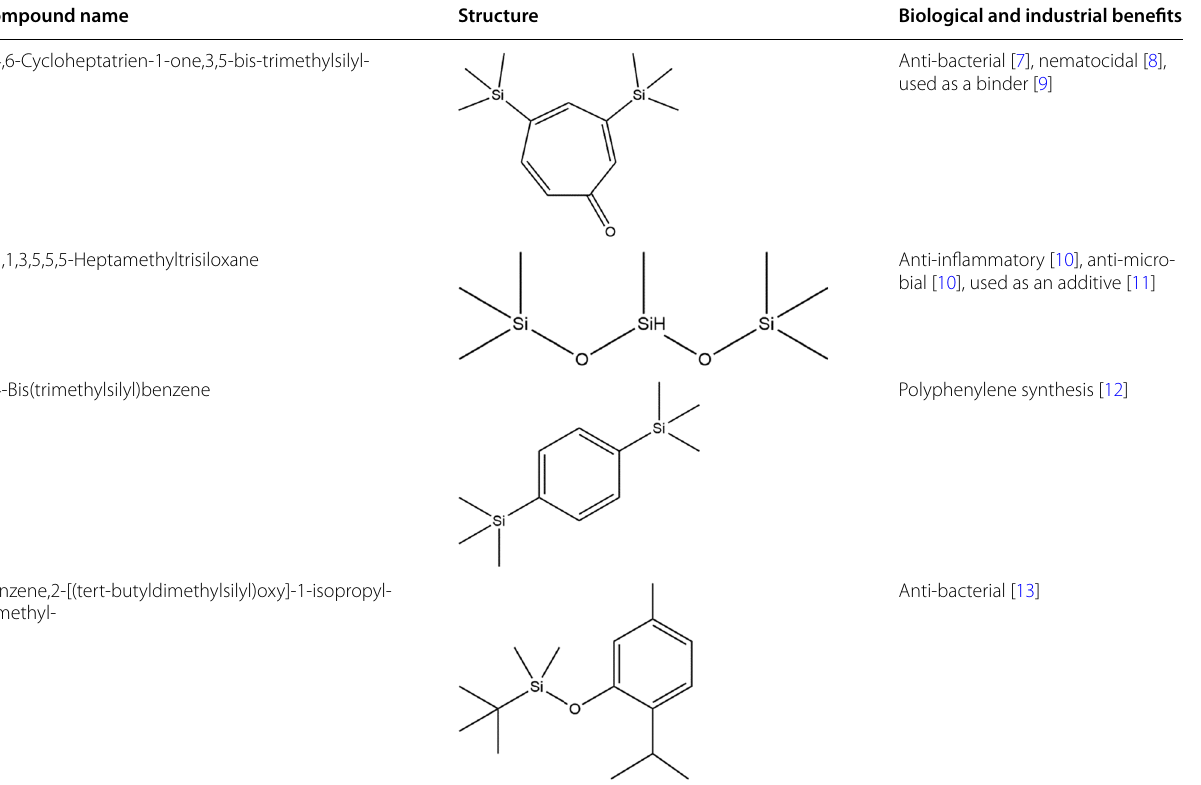
Table 2 Biological and industrial benefits of the identified compounds from W. edulis methanol stem extract Compound